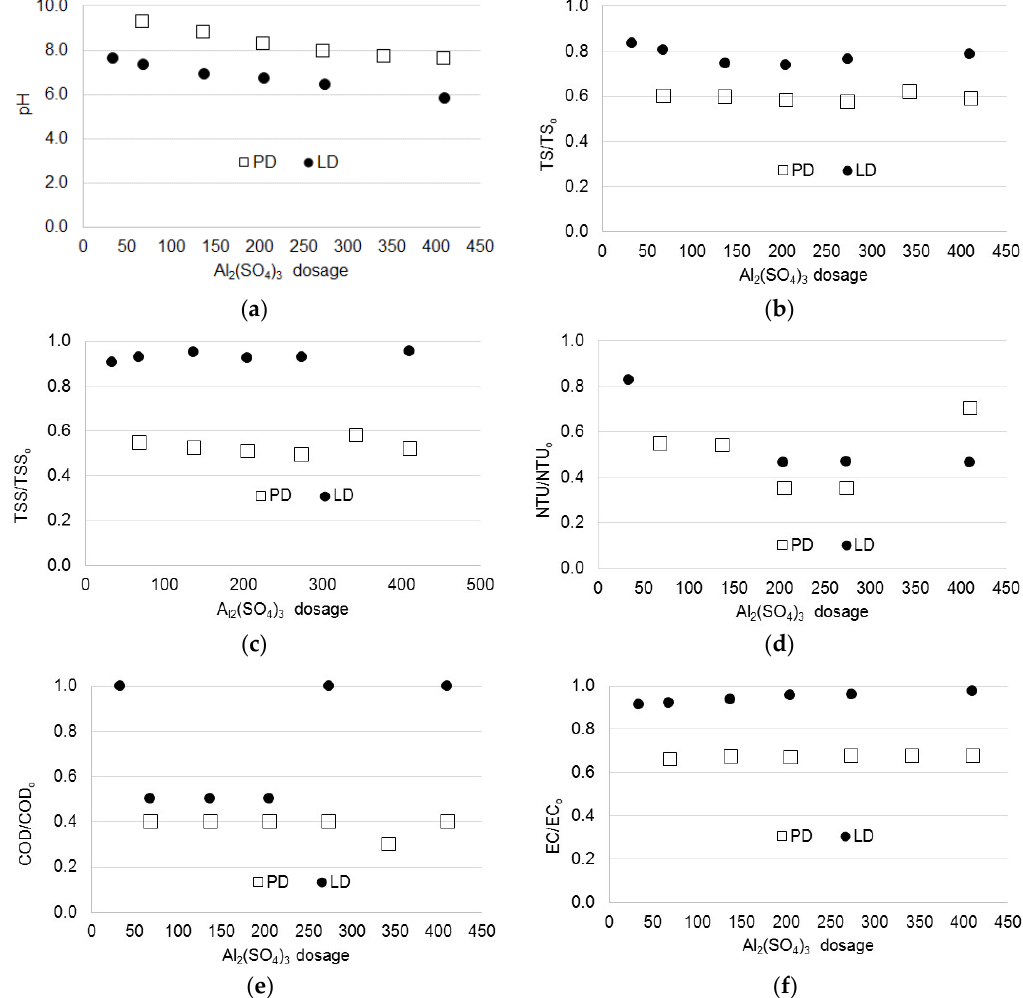
Figure 3. Effect of coagulant dosage (mg/L) on bulk parameters removals for both graywaters. PD: Powder detergent; LD: Liquid detergent.